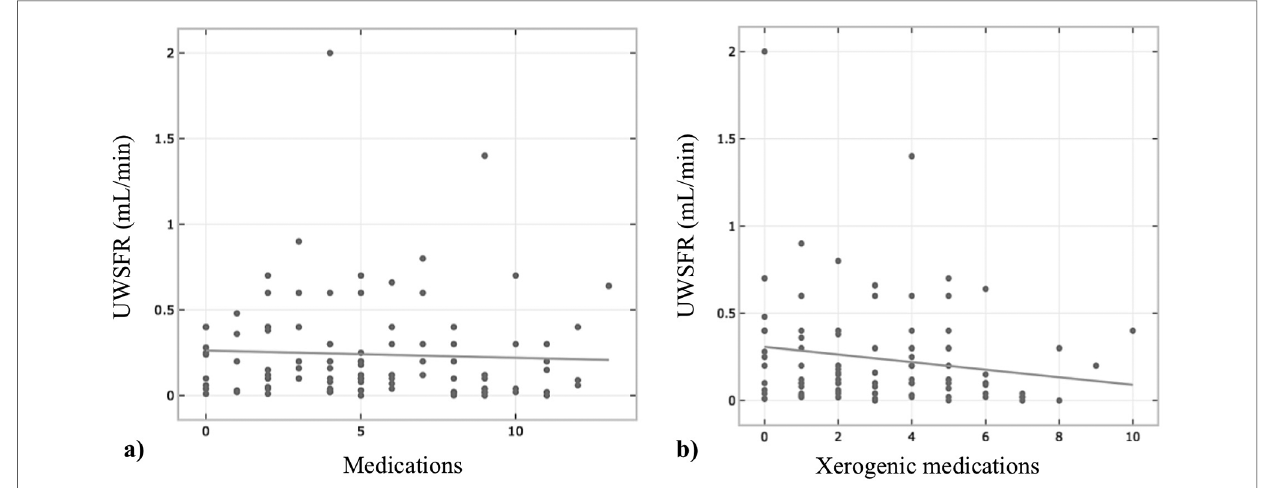
FIGURE 1 Relationship between number of medications ( A ) and xerogenic medications ( B ) and unstimulated whole salivary fl ow rate (UWSFR) ( N